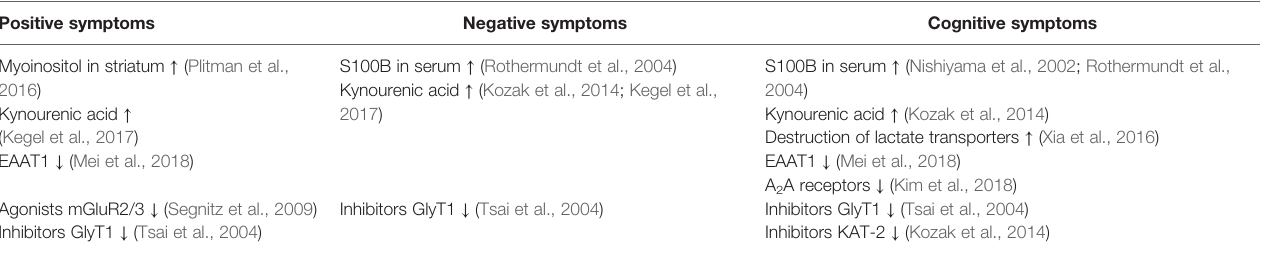
TABLE 1 | Association between symptoms of schizophrenia and metabolites, receptors, and pharmacological agents related with astrocytes. Positive